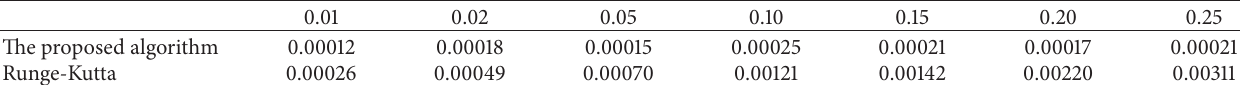
Table 1: The estimated means of |⟨𝑒|𝜓 𝑟 (𝑇)⟩| 2 minus the exact values obtained by the analytical solution of 𝜌 11 (𝑡) , that is, (|⟨𝑒|𝜓 𝑟 (𝑇)⟩| 2 −𝜌 11 (𝑡)) , for different step sizes Δ𝑡 and methods.